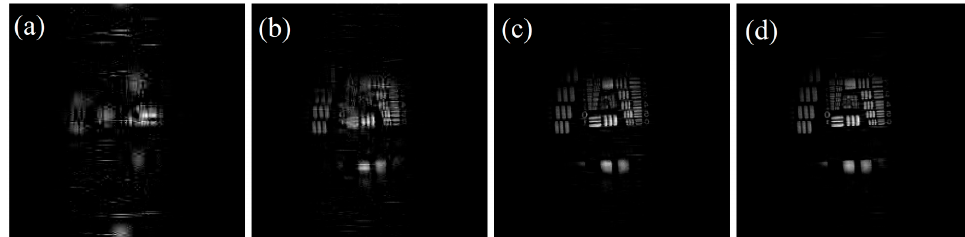
Figure 4. Reconstruction results under different compressive sampling ratios. ( a – d ) are reconstruction results with the sampling ratio of 0.1, 0.25, 0.5 and 0.6. The image size is 256 × 256 pixels. The measurement matrix is sparse binary random matrix.